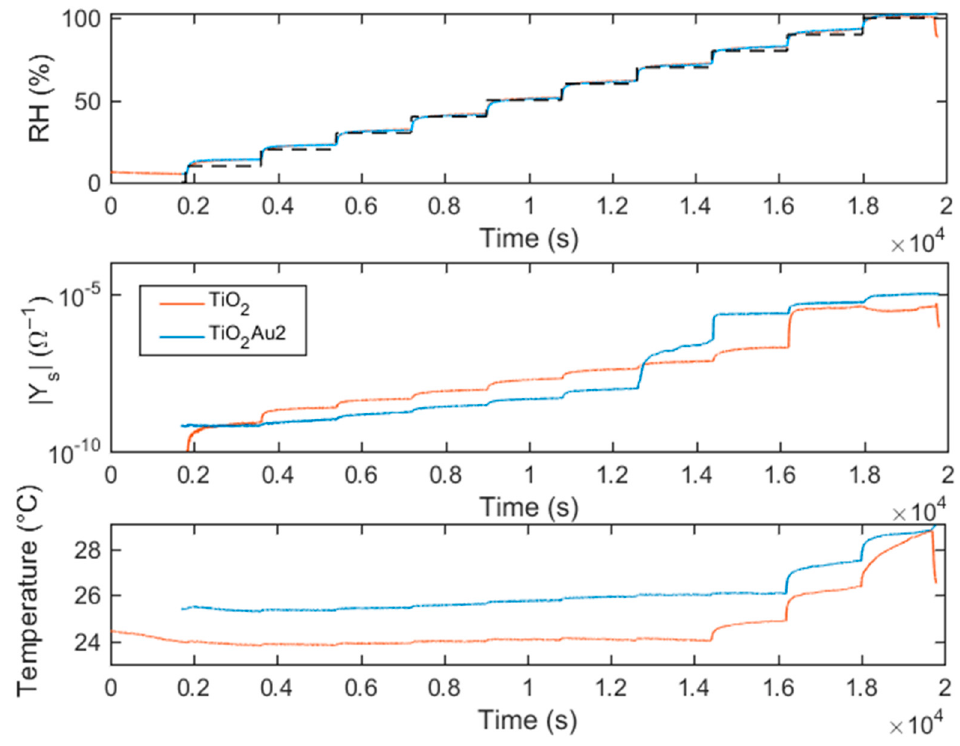
Figure 14. Dynamical response of the TiO 2 (blue line) and TiO 2 Au2 (red line) sensing films to increasing RH steps. The middle plot shows the measured sensing-film admittance magnitude |Ys| versus time. During the measurements, increasing 10% RH steps of 30 min were applied (upper plot, where the dashed black line refers to the theoretical RH level set in the measurement chamber). The RH (upper plot) and the temperature (lower plot) were measured with the commercial sensors in the measurement chamber.